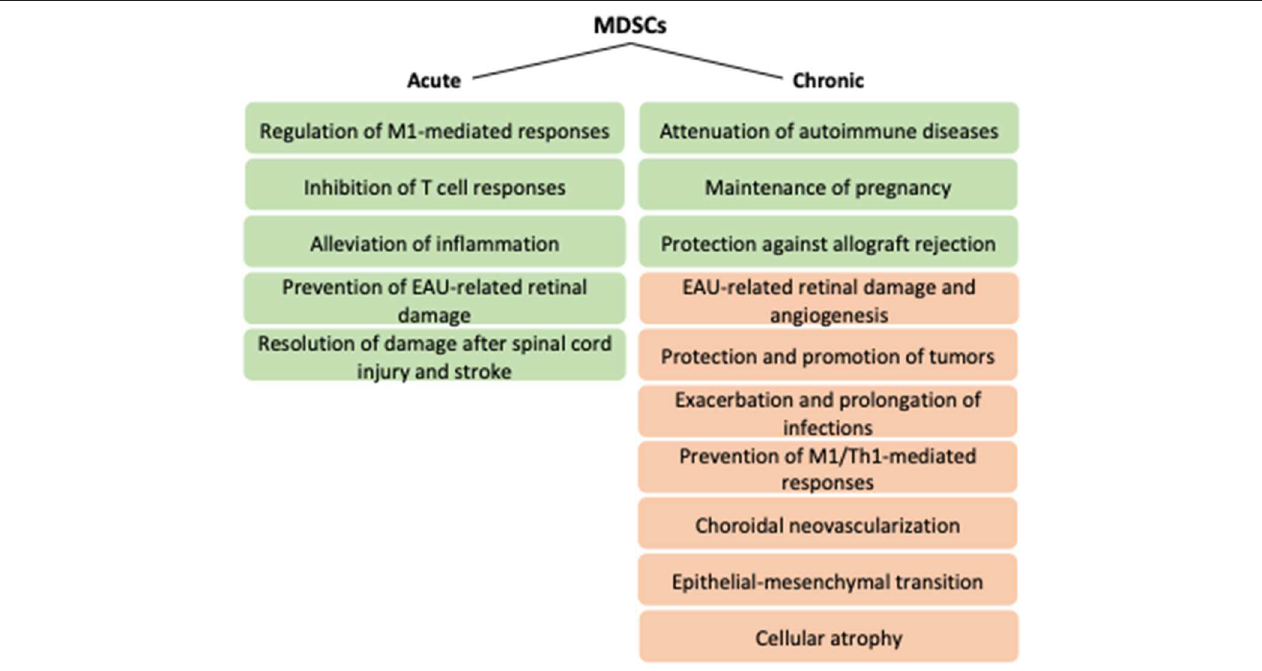
FIGURE 2 | Potential functions of MDSCs upon acute versus chronic conditions. Green and orange boxes refer to positive and negative effects, respectively. EAU, experimental autoimmune uveitis; M1, type 1 macrophage; MDSCs, myeloid-derived suppressor cells; Th1, type 1 helper T cell.